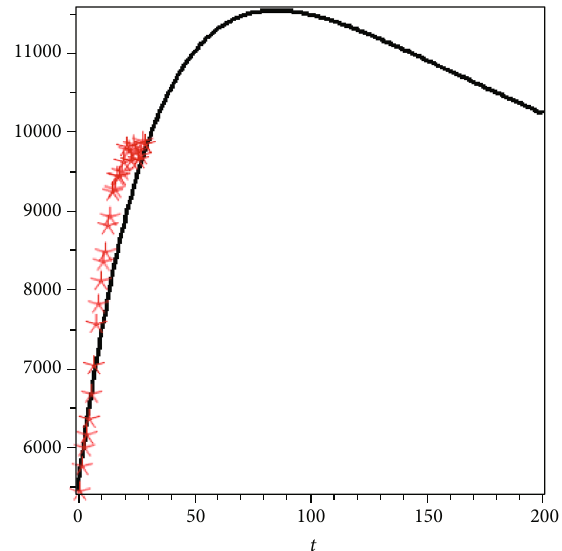
Figure 5: Comparing the prediction of model (46 – 49 (black line) with real data of Saudi Arabia (red asterisks) for β = 2 : 79 : 10 − 7 and R 0 = 1 : 108